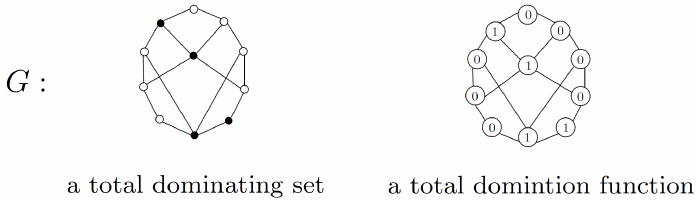
Figure 1: A total dominating function in a graph.